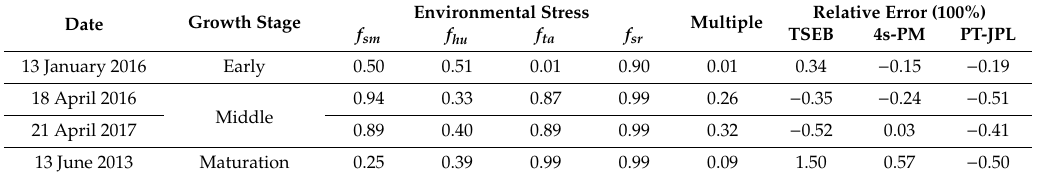
Table 5. Environmental stress and LE estimation relative percentage errors for